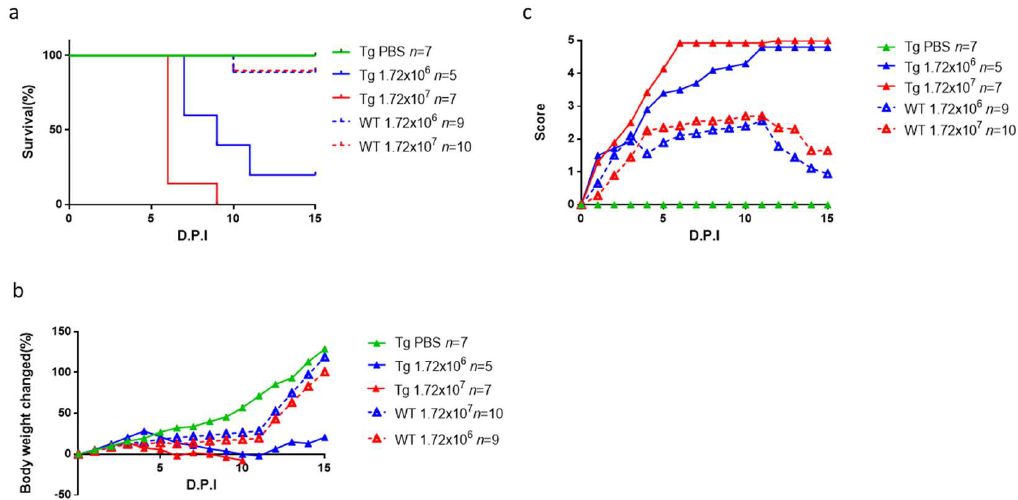
Figure 4. Pathogenesis and lethality of hSCARB2-Tg mice infected with CVA10. Scoring of ( a ) disease score, ( b ) loss of body weight, and ( c ) survival rate in 12-day-old hSCARB2-Tg and WT mice injected s.c. with 1.72 × 10 6 and 1.72 × 10 7 pfu of CVA10, individually, were monitored daily (day post-infection, D.P.I.) for 15 days and assessed following the criteria described in the Materials and Methods section. The same age of Tg mice injected s.c. with PBS as control was included. The number ( n ) of mice per group was shown.